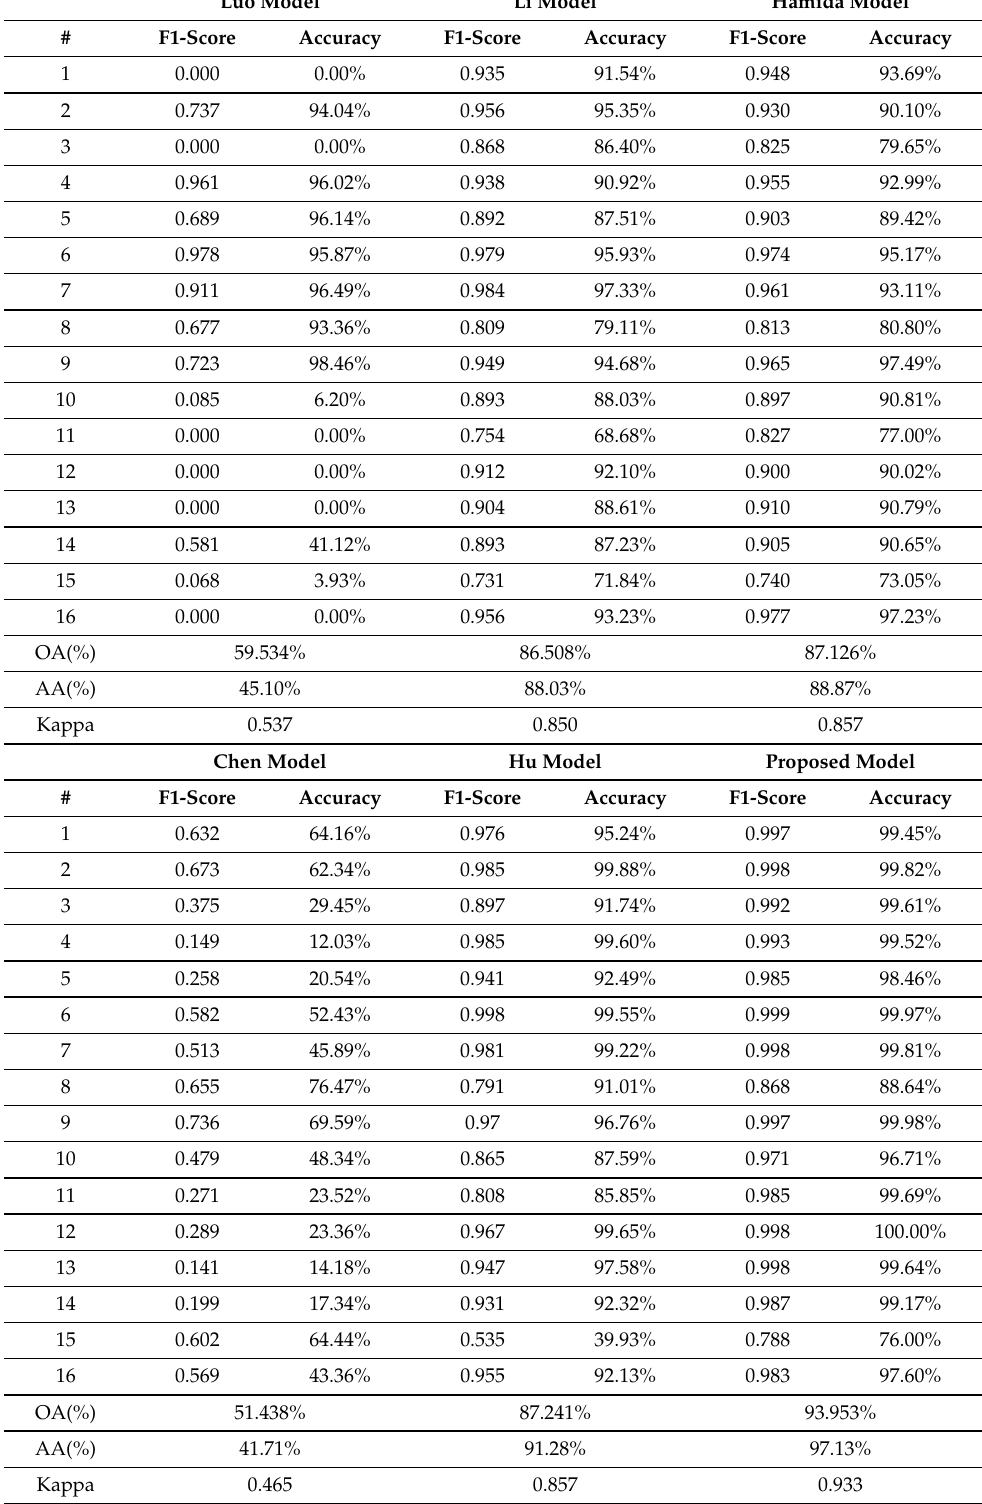
Table 11. Classification results of the Salinas dataset to which random spatial information is